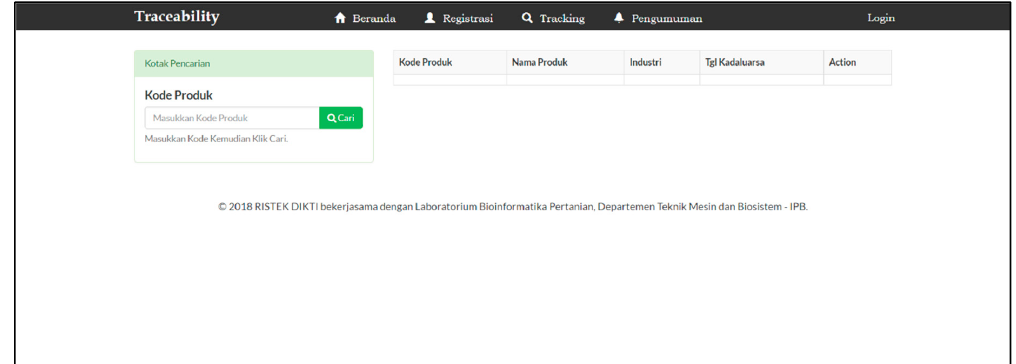
Figure A6. Tracking process for consumers.